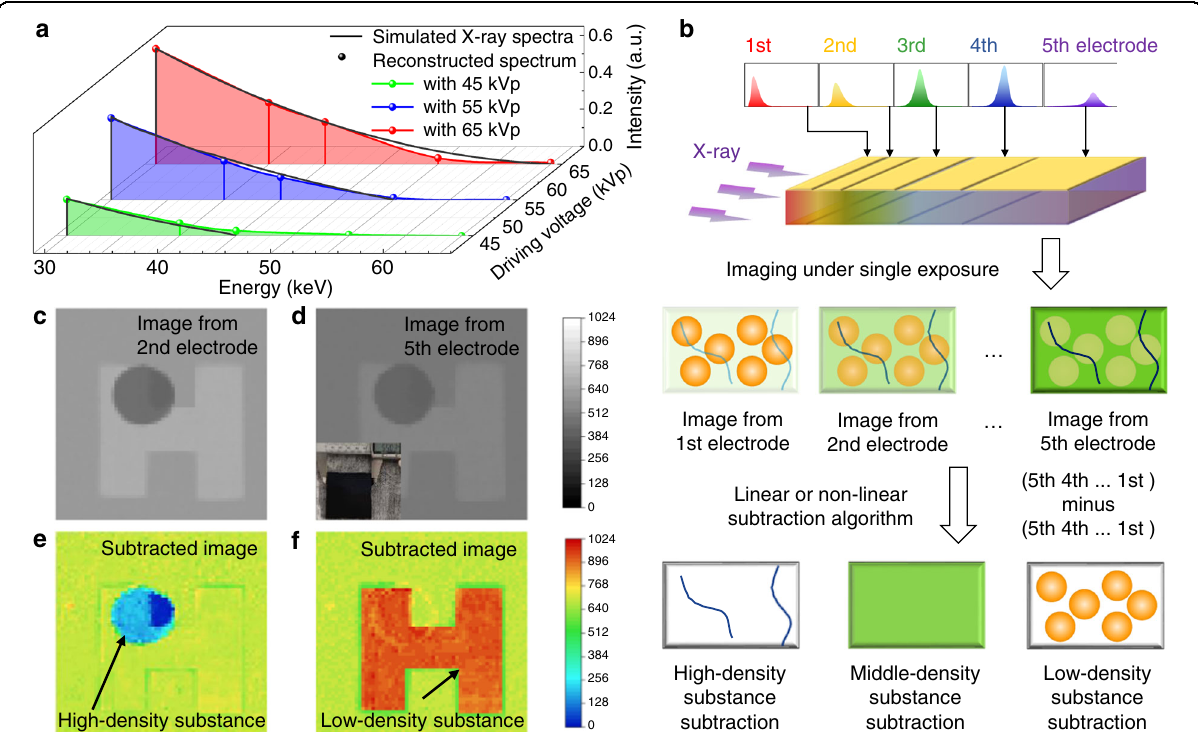
Fig. 4 The applications of the multi-energy X-ray detector. a The reconstructed X-ray spectra obtained from the response signals of the detector, and the simulated X-ray spectra by Monte Carlo, when the driving voltages of the X-ray tube are 45, 55, 65 kVp. b Schematic diagram of multi-energy X-ray imaging. The X-ray energy from low to high is represented by the color from red to purple. The dark-blue lines represent high-density substance, yellow-green rectangles represent medium-density substance and orange balls represent low-density substance. c The image of our arti fi cial sample from 2nd electrode. d The image from 5th electrode. The inset is the optical photo of the sample. e The subtracted pseudocolor image for high-density substance CaCO 3 tablet. f The subtracted image obtained for the low-density paraf fi n ‘ H ’ letter. The pixel size in c – f is 0.85